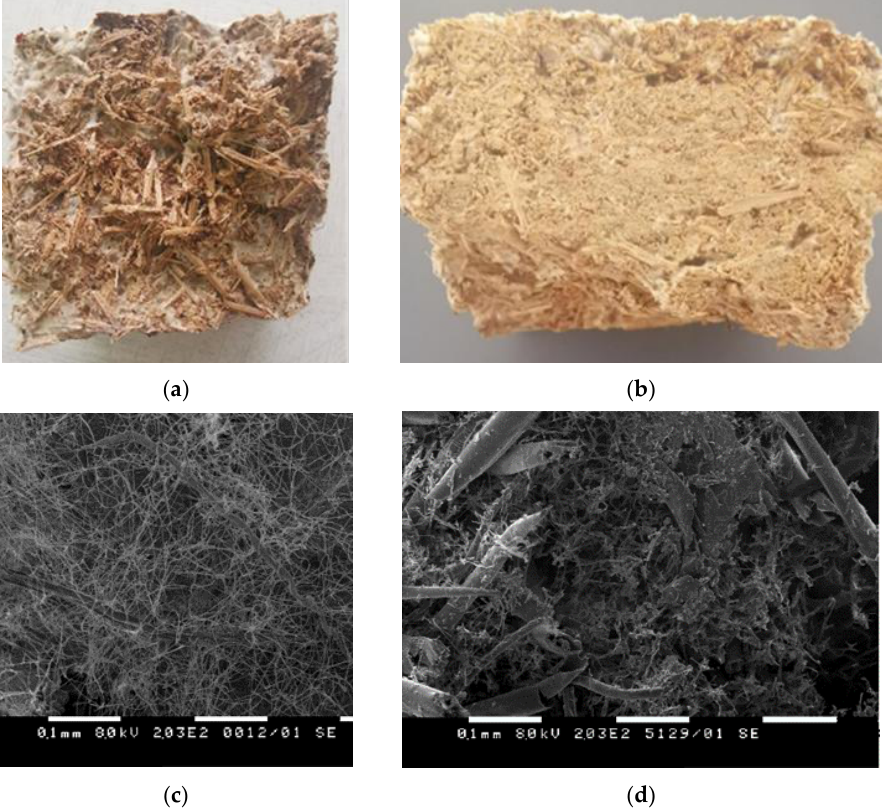
Figure 5. Visual observation of cross - section of mycelium ( a ) steam distilled lavender straw (SDLS) - and ( b ) hexane extracted rose flowers (HERF) - based bio - composites; Scanning Electron Microscopy (SEM) images of cross - section of ( c ) SDLS - and ( d ) HERF - based bio - composites .